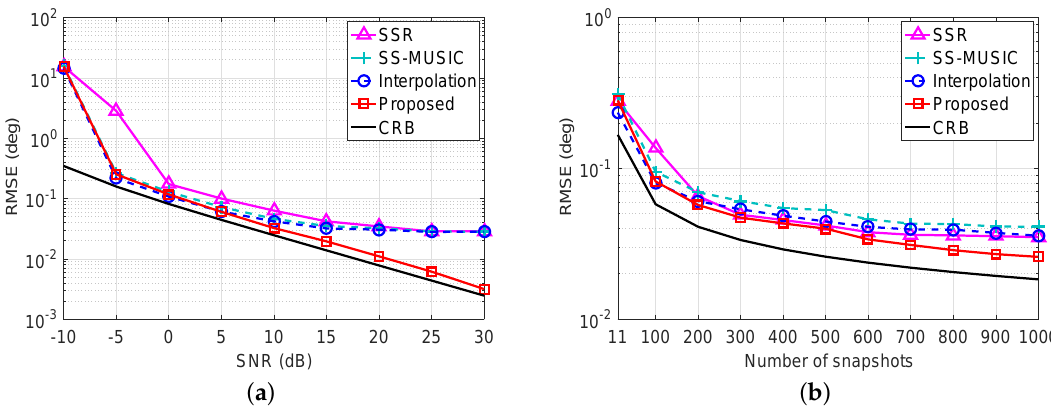
Figure 5. Root mean square error (RMSE) performance comparison with a single source, whose direction is randomly selected from N ( 0 ◦ ,1 ◦ ) in each Monte Carlo trial. ( a ) RMSE versus SNR with L = 50; ( b ) RMSE versus the number of snapshots with SNR = 0